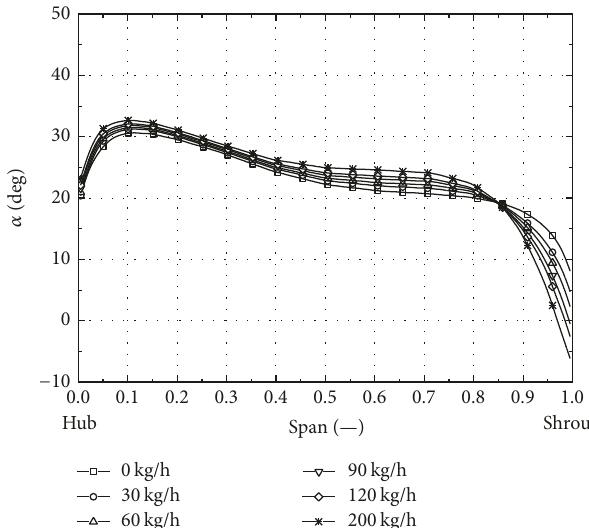
Figure 21: Flow angle with different steam injection at the diffuser inlet.